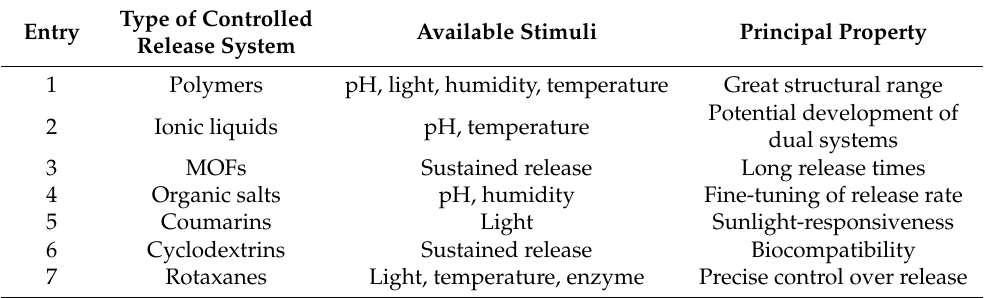
Table 1. General considerations of the different scaffolds employed for the controlled release of scents.